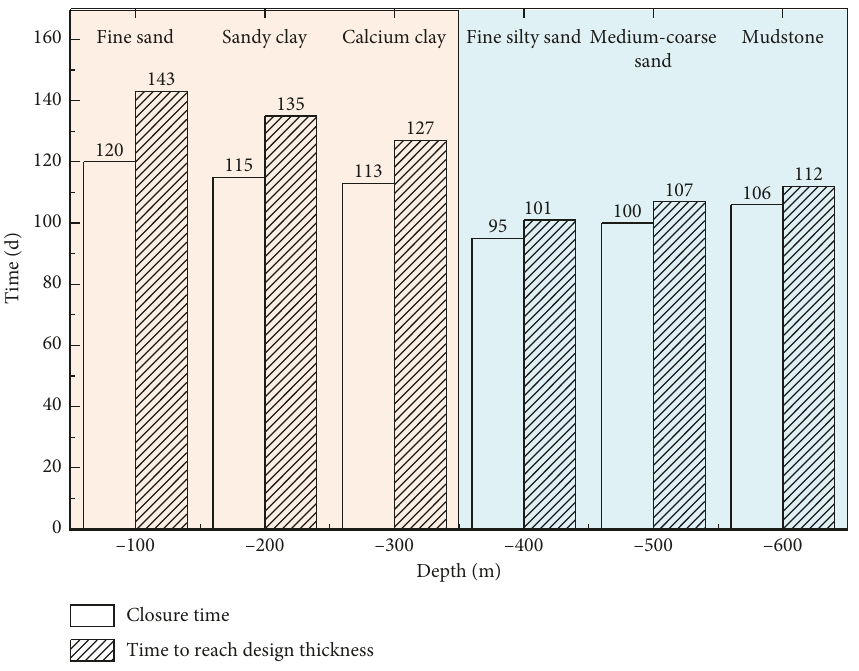
Figure 13: Freezing time of each layer’s frozen wall and time to reach the design thickness.